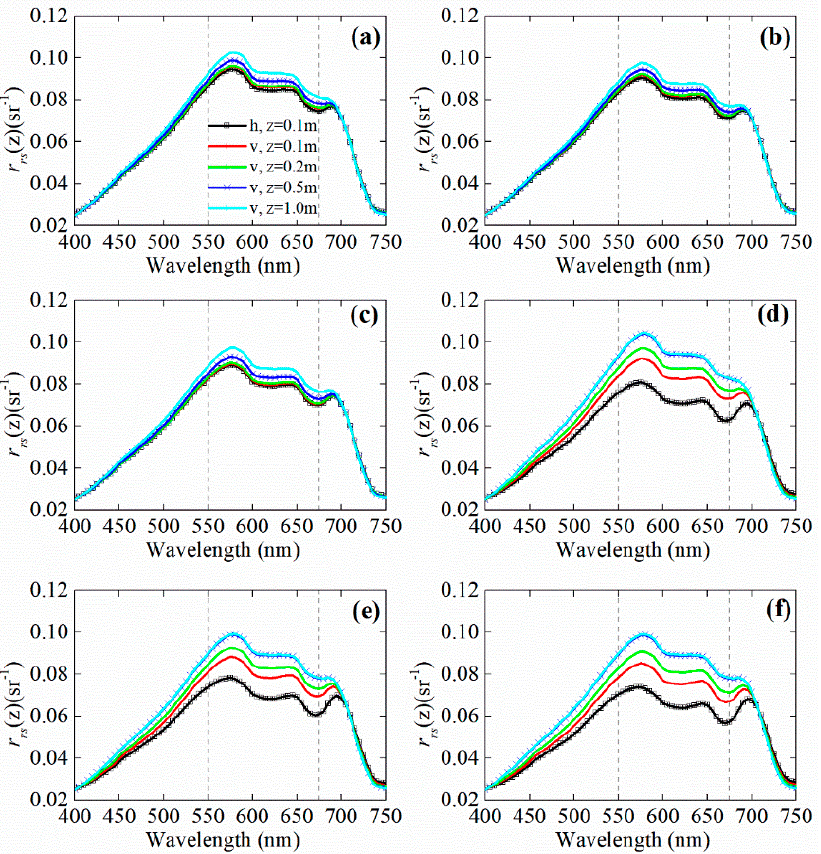
Figure 2. r rs (z) spectrum of Chl a (z) profiles: ( a ) L1 (5, 16, 0.6), ( b ) L2 (10, 16, 0.6), ( c ) L3 (10, 21, 0.6), ( d ) L4 (5, 16, 0.2), ( e ) L5 (10, 16, 0.2), and ( f ) L6 (10, 21, 0.2) at different water depths (z = 0.1, 0.2, 0.5, 1.0 m). “h” represents that the Chl a value was vertical homogeneous, and the water depth is 0.1 m. “v” represents the vertical inhomogeneous cases. r rs (z) profiles at 550 and 675 nm (grey dash lines) shown in Figure 3a,b.